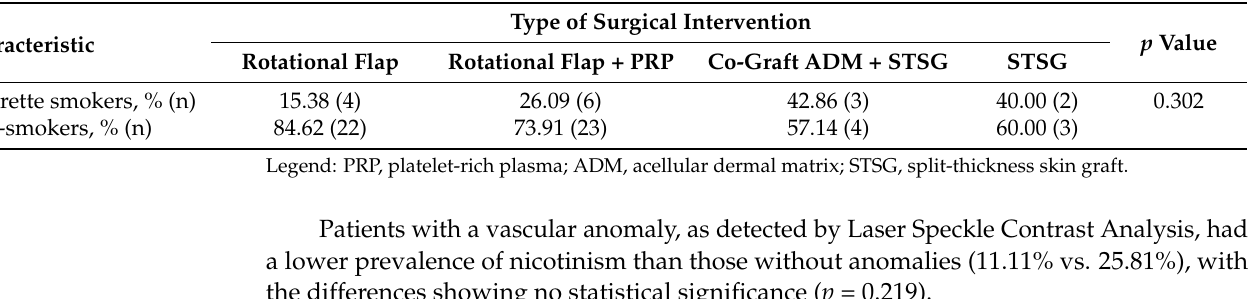
Figure 6. Complications after surgery regarding the type of surgical intervention: ( A ) in two weeks; and ( B ) a six-month follow-up. Legend: PRP, platelet-rich plasma; ADM, acellular dermal matrix; STSG, split-thickness skin graft.